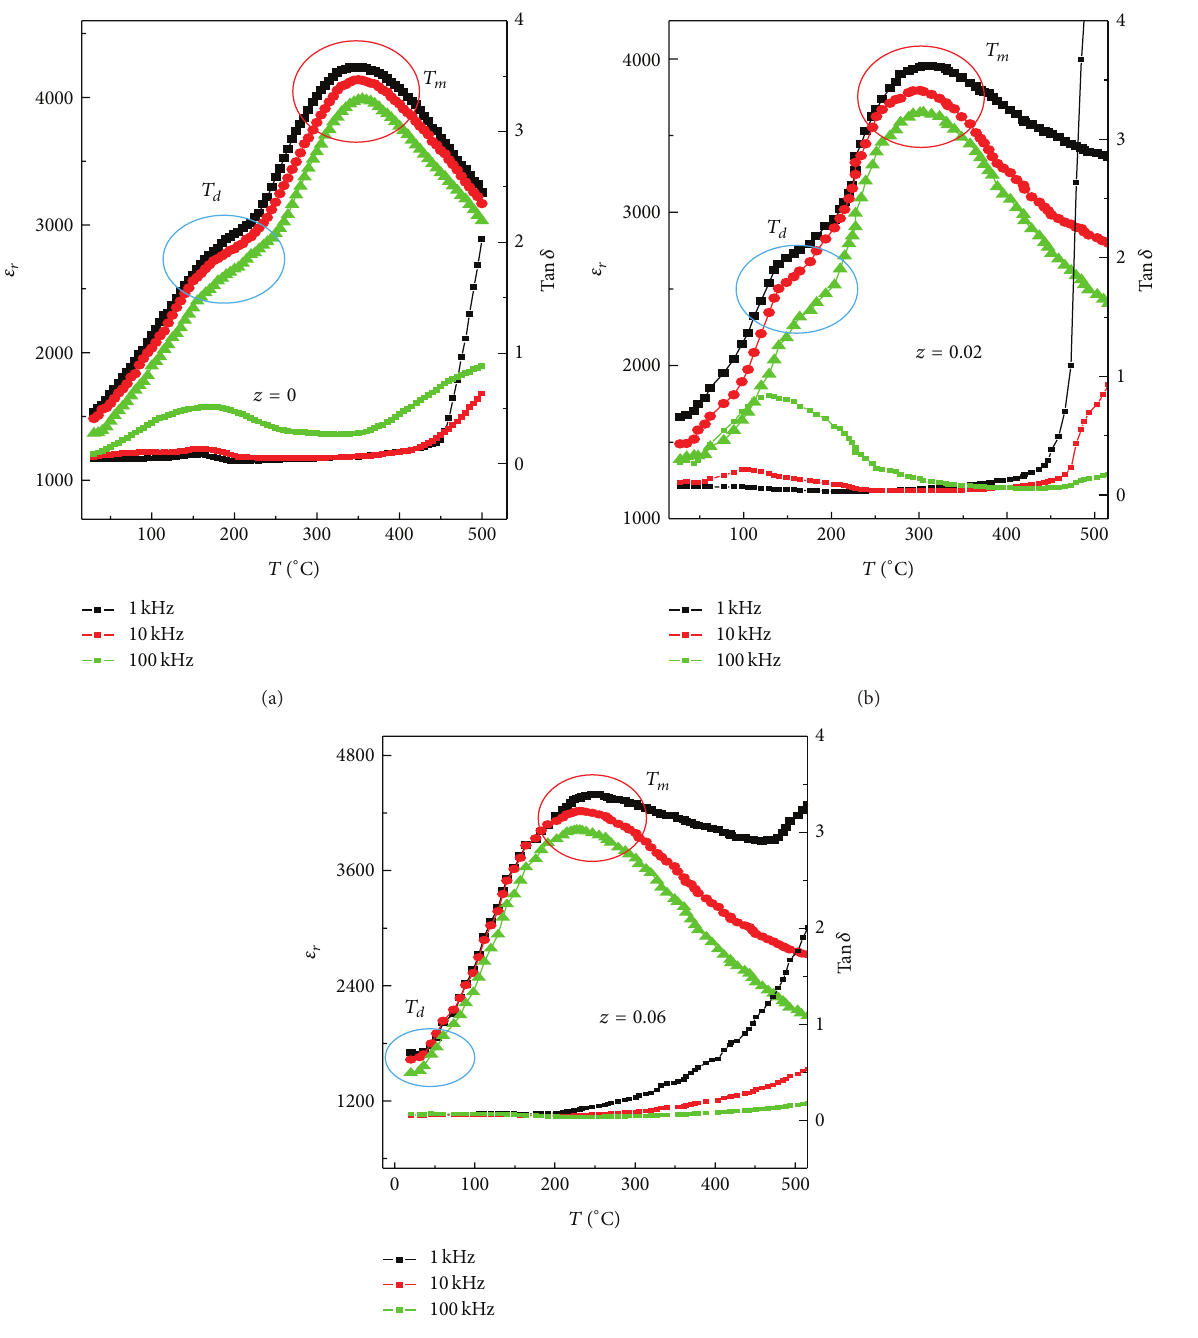
Figure 3: The temperature dependence of 𝜀 𝑟 and tan 𝛿 of [ 1 − 𝑧 (BLNLT)- 𝑧 (BT)] system for samples 𝑧 = 0 , 0.02, and 0.06 at 1kHz, 10kHz, and